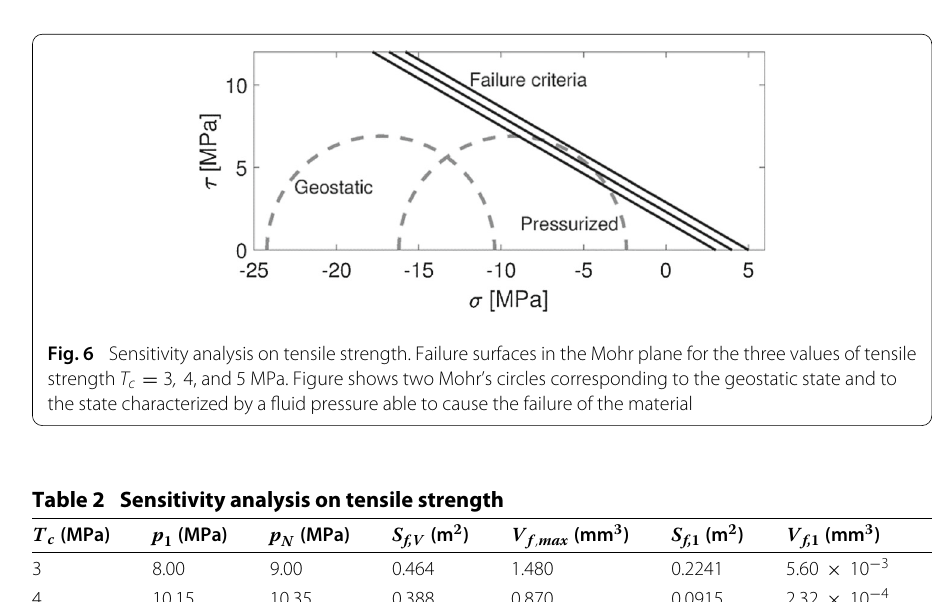
Table 2 Sensitivity analysis on tensile strength